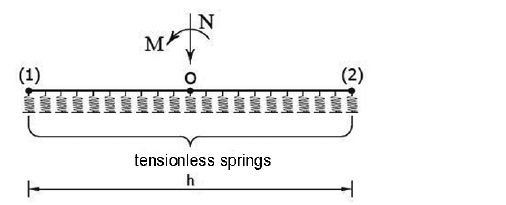
Fig. 10. Analysis model of footing in SAP2000